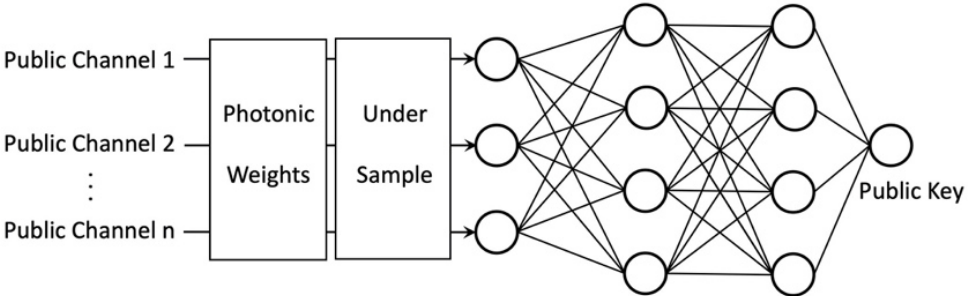
Figure 8. Public key generation from the under-sampled public channel data.